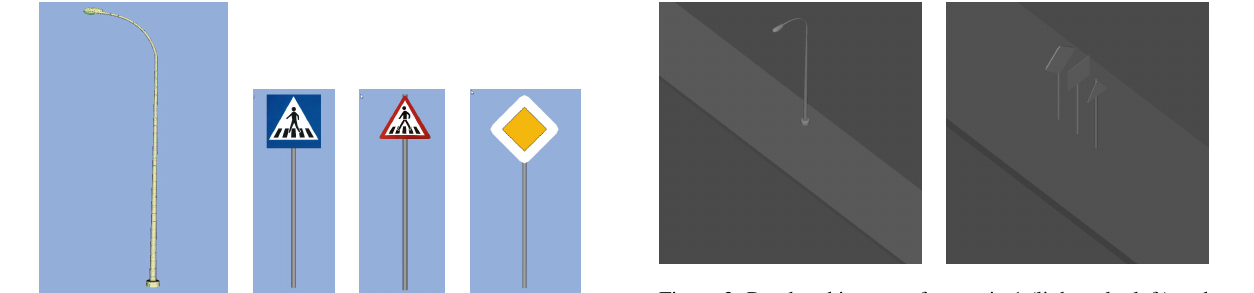
Figure 3. Rendered images of scenario 1 (light pole; left) and scenario 2 (street signs; right) for aspect angle 45 ◦